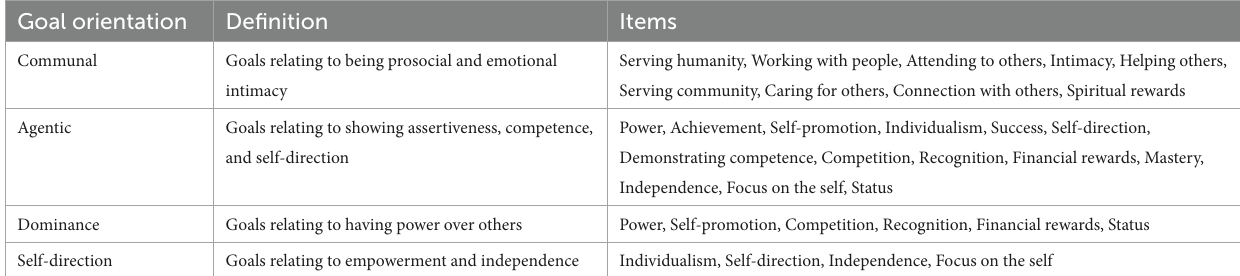
TABLE 1 Dimensions of goal orientations. Goal